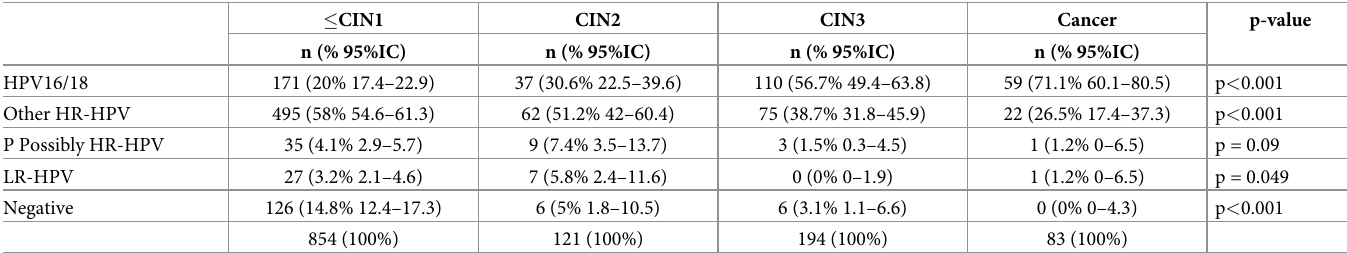
Table 2. Prevalence of HPV genotype risk-based groups within histological diagnoses in HPV screened positive